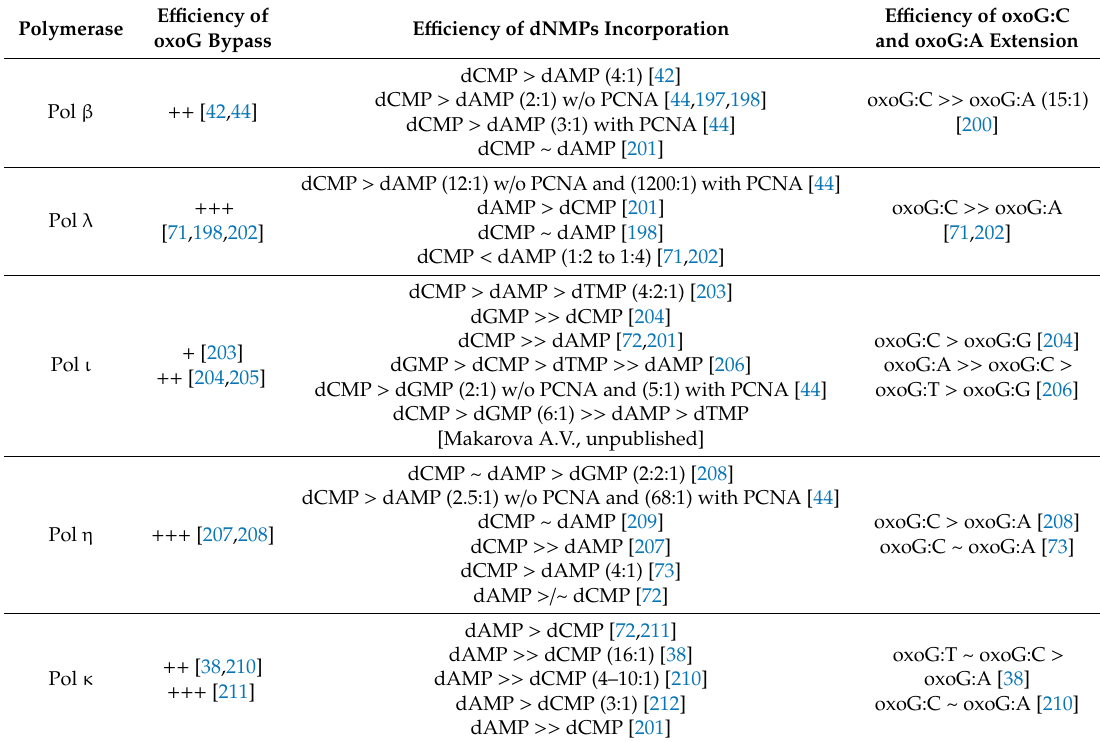
Table 2. Activities of human X- and Y-family DNA polymerases opposite oxoG in